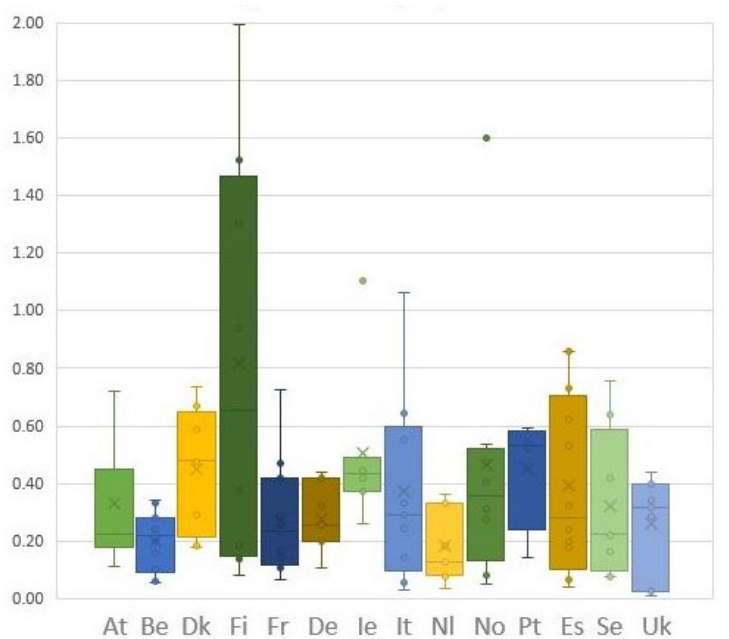
Figure 2. Disagreement in parties’ Left–Right position